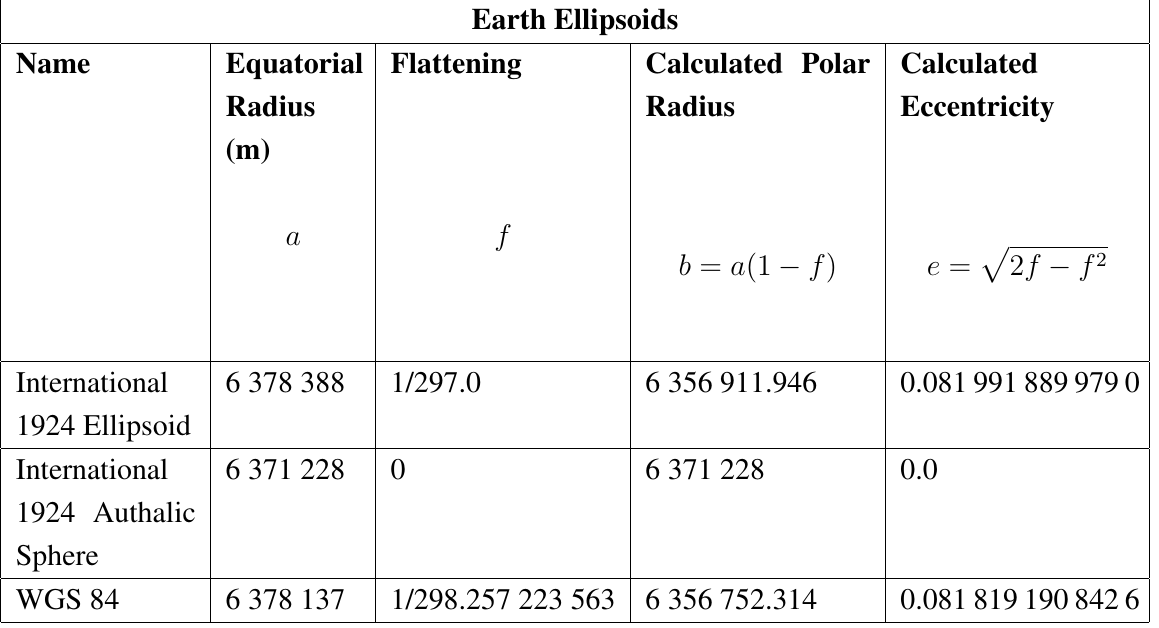
Table 1. Characteristics of Earth ellipsoids (Table 2.1, p. 10 in [21] and Appendix B) discussed in the